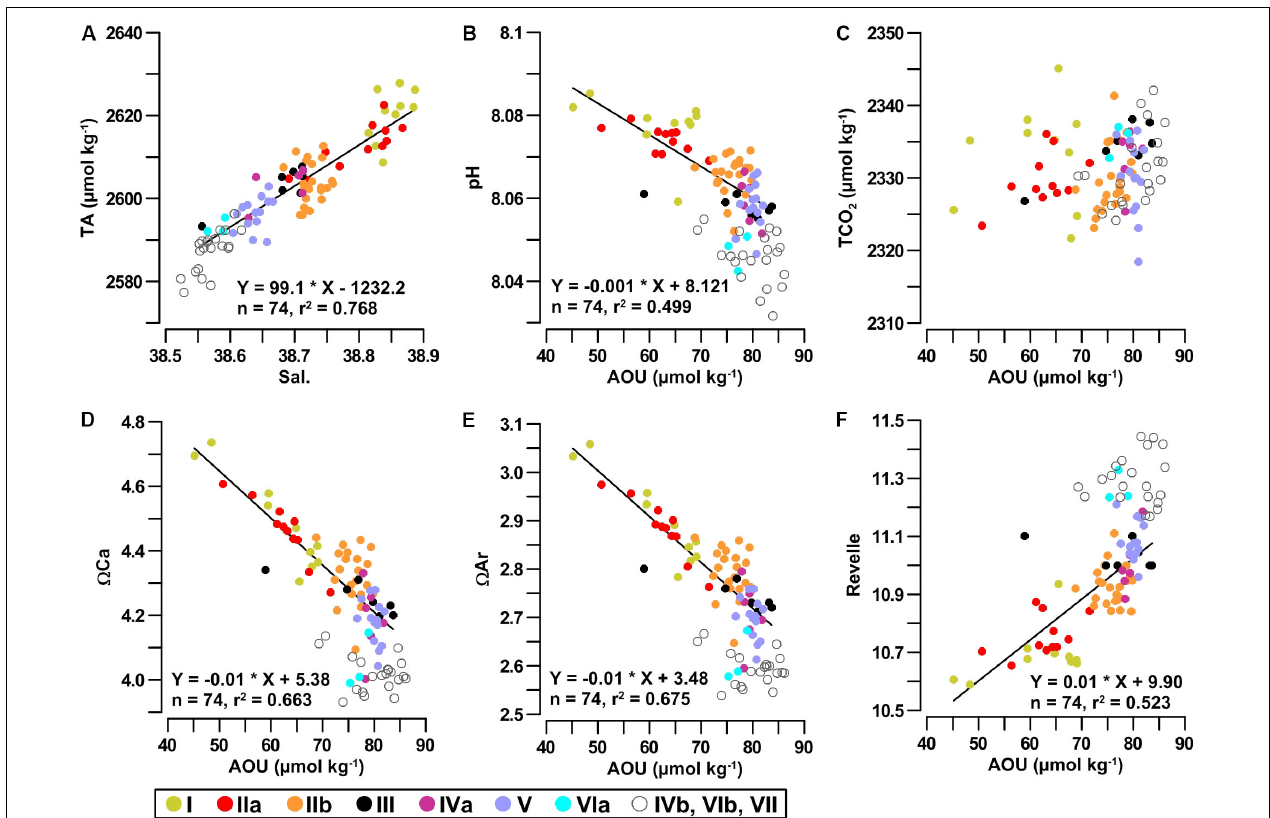
FIGURE 5 | Relationships and linear regressions among in situ carbonate system parameters with salinity and AOU in the IW in the subregions from I to VIa. White dots indicate the data of the last three subregions (IVb, VIb and VII). The color code of the dots is the same as in Figures 1 , 2 . (A) TA vs. Salinity, (B) pH vs. AOU, (C) TCO 2 vs. AOU, (D) (cid:127) Ca vs. AOU, (E) (cid:127) Ar vs. AOU, and (F) Revelle vs.